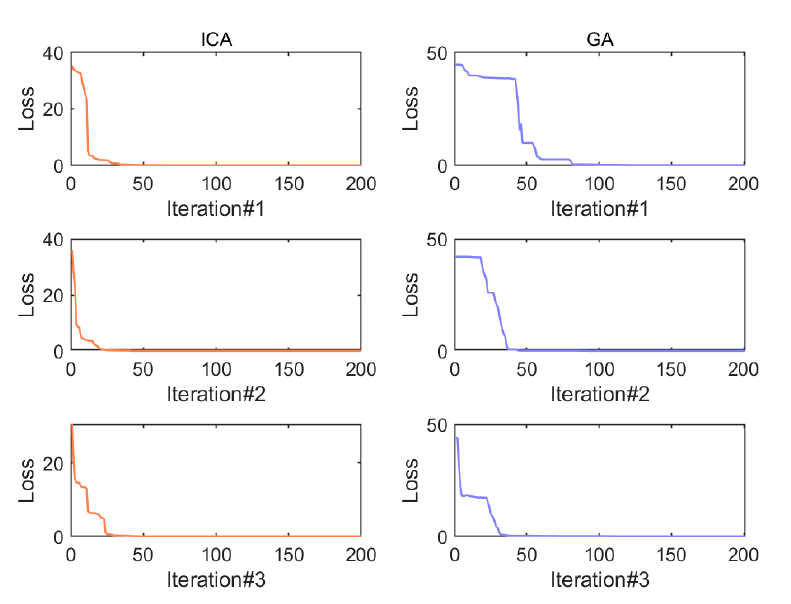
Figure 4. Values of loss during the iterations of ICA and GA. Table 3. The promoting percentages of the SAE models.